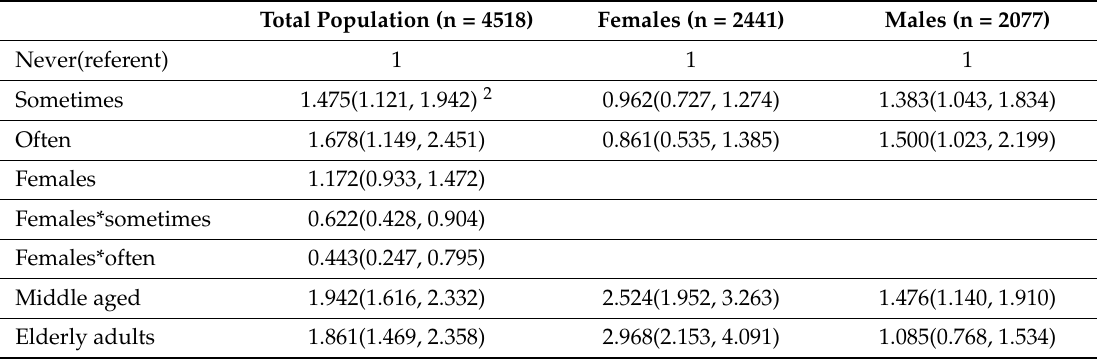
Table 3. Multivariable adjusted 1 association between Mets and